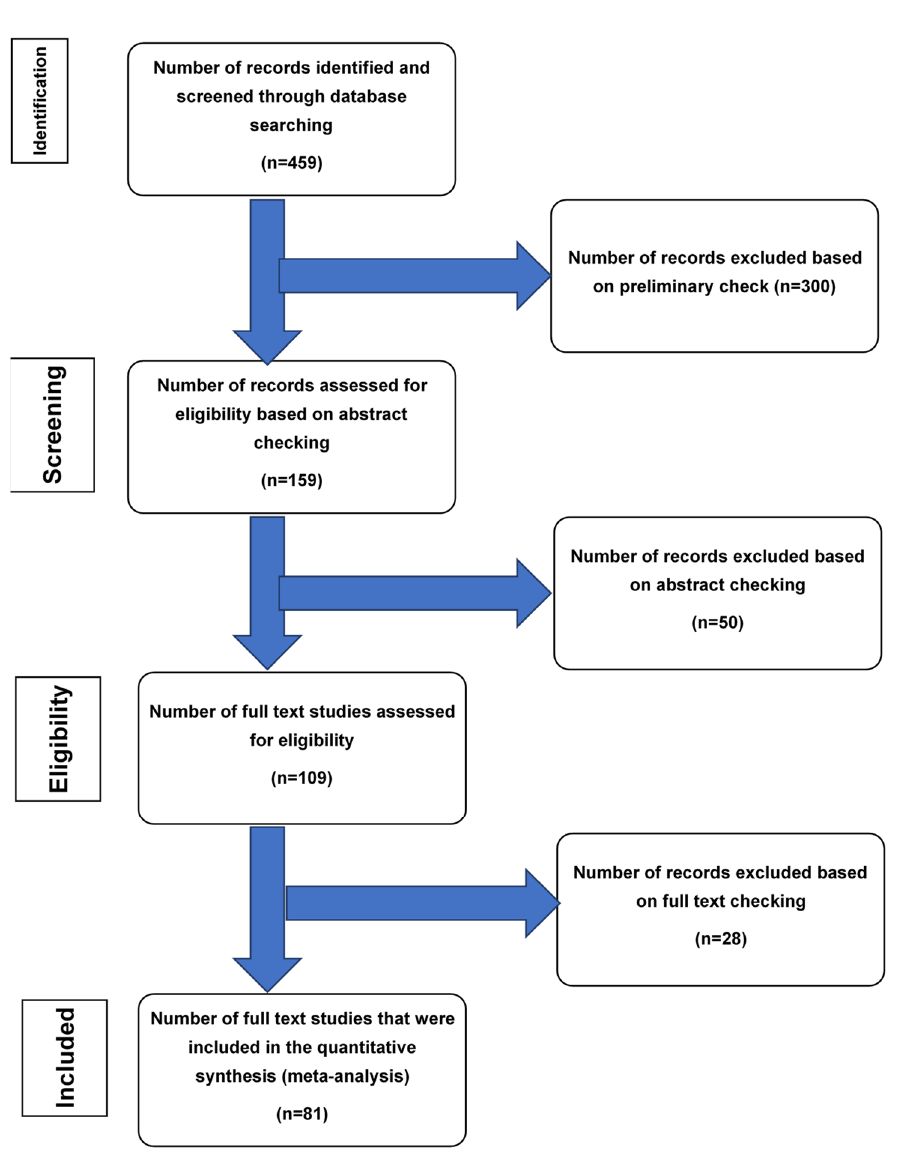
Figure 1. Flow chart of literature search and study selection for cases of neurogenic appendicitis.